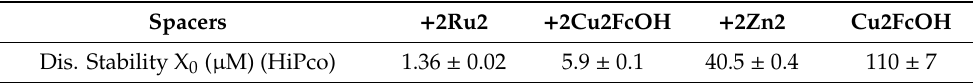
Figure 5. Dispersion stability measurements of HiPco SWCNTs in the presence of various molecular spacers. The onset of aggregation for dinuclear molecular spacers with various charge states was calculated from these data. The left panel compares the strong electrolyte +2Ru (black) to the weak electrolyte +2Zn2 (red) +2Zn2 (red), and the right panel compares +2Zn2 (red) to the neutral Cu2FcOH (black). All spacers were mixed into dispersed HiPco SWCNTs (average diameter 0.95 nm). Table 1. Dispersion stabilities of HiPco SWCNTs in DMF with +2Ru2, +2Zn2 , +2Cu2FcOH , and Cu2FcOH coordination complexes added until the concentration was higher than the diffusion- limited colloid aggregation concentration.